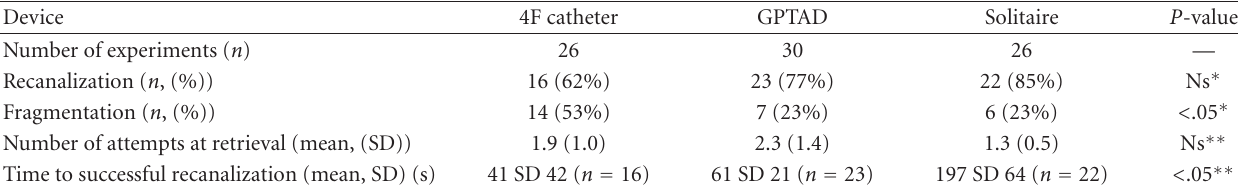
Table 1: Summary of results for each